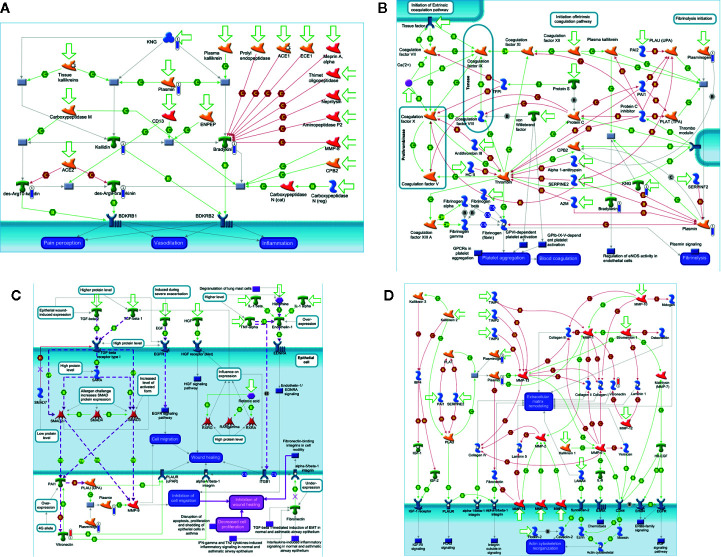

In silico analysis reveals the main biological networks differentially expressed in the blood of ALL-B compared to the bone marrow at diagnosis, before treatment start (D0). (A) Protein folding and maturation, (B) Blood coagulation, (C) Wound healing, and (D) extracellular matrix remodeling. Experimental data from all files is linked to and visualized on the maps as thermometer like figures. Upward thermometers have red color and indicate up-regulated signals and downward (blue) ones indicate downregulated expression levels of the genes.